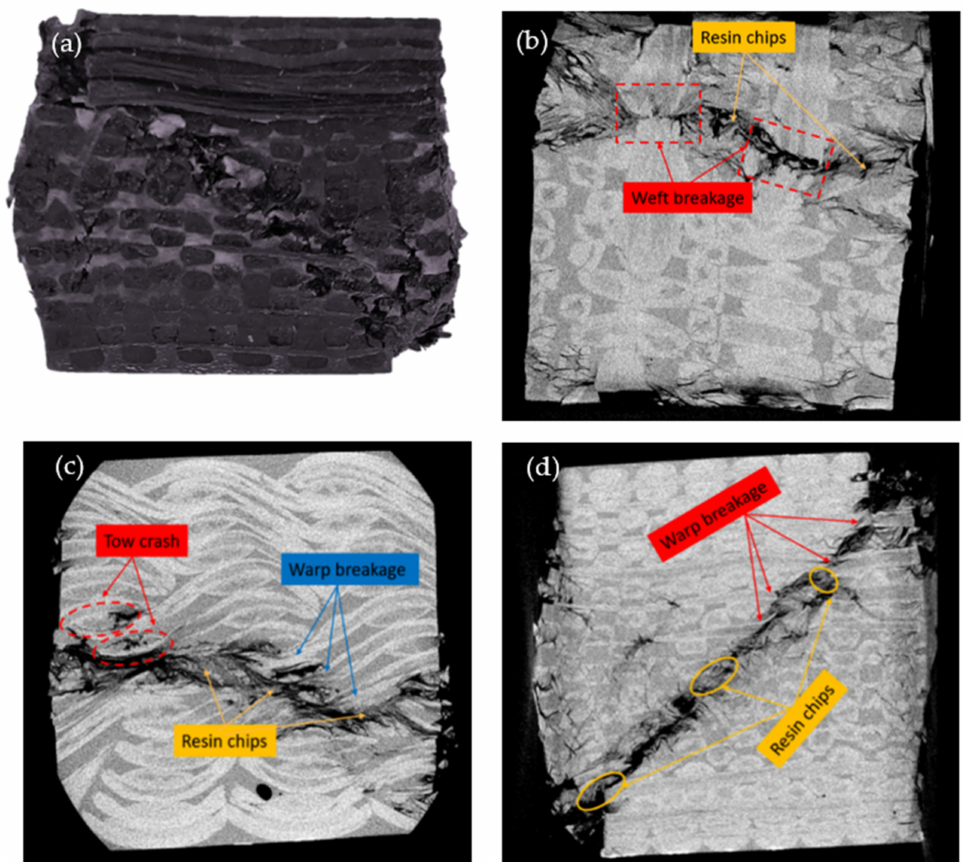
Figure 7. Damage pattern of quasi-static compression test in the thickness direction: ( a ) macroscopic damage images; ( b ) warp direction slicing; ( c ) weft direction slicing; ( d ) thickness direction